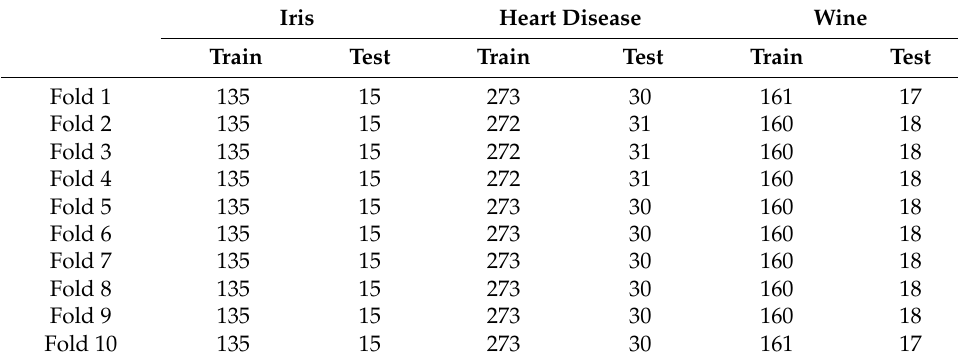
Table 1. Number of samples in each fold for all datasets.